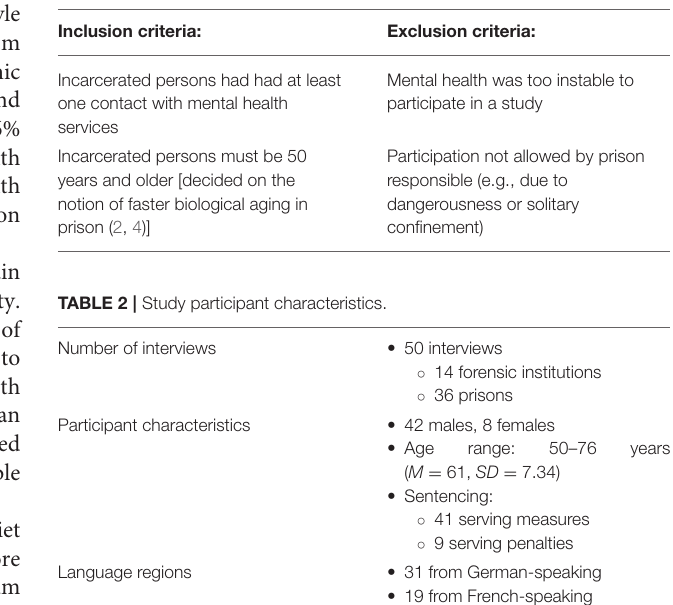
TABLE 1 | Criteria for our study participants.